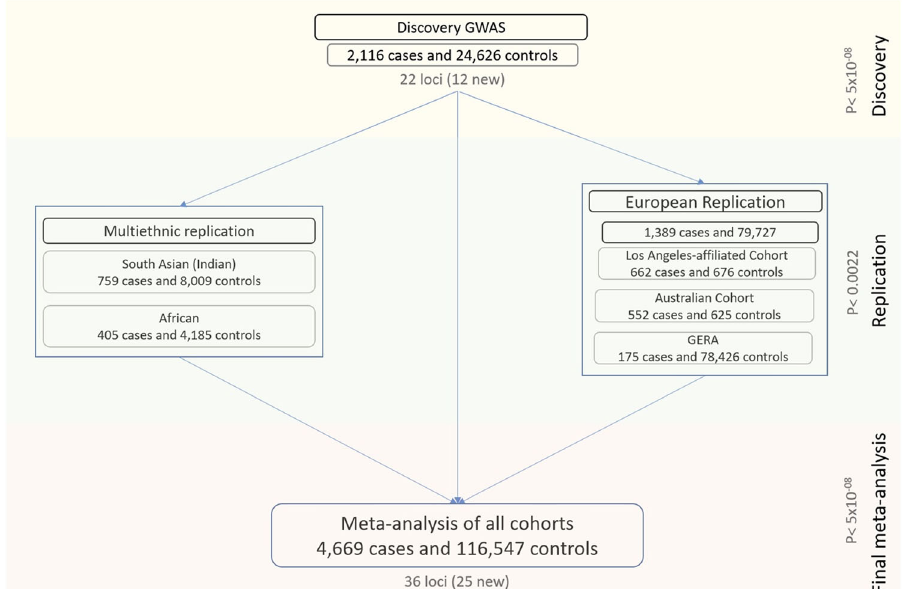
Fig. 1 Work fl owchart showing the fl ow of the genetic association analyses described in the manuscript. There were three main phases: a discovery in a European cohort of 2116 cases and 24,626 controls, a replication in a combined meta-analysis of three other European cohorts as well as in two smaller non-European cohorts, and a fi nal meta-analysis involving all the multi-ethnic cases and controls from the previous